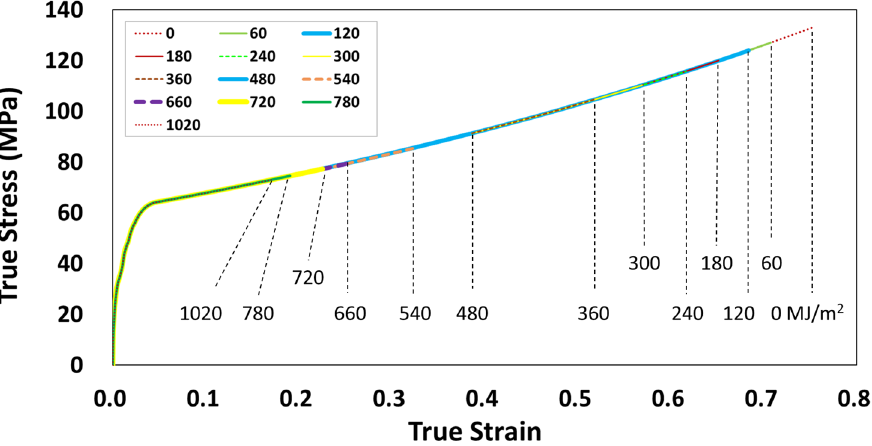
Figure 19. True stress–strain curves of weather-exposed PC used in collision impact simulation.